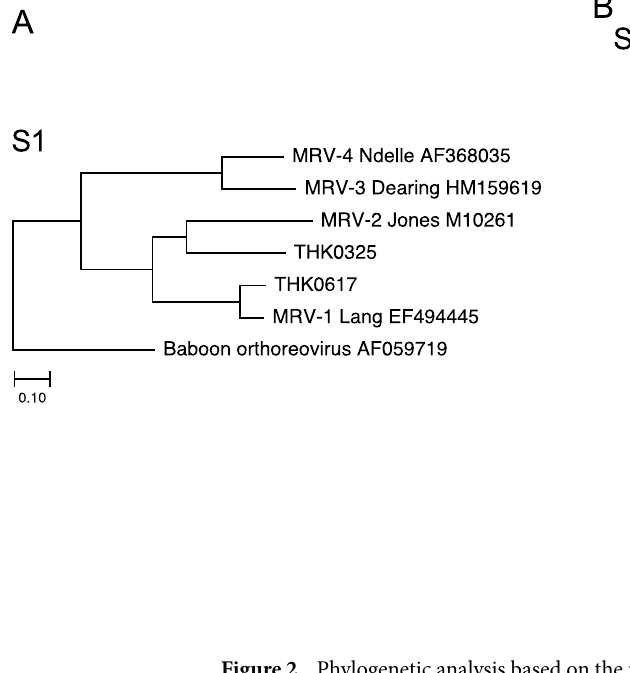
Figure 2. Phylogenetic analysis based on the nucleotide sequences of novel MRV isolates. Phylogenetic trees for the S1 segment were constructed through the maximum-likelihood method and 1000 bootstrap replicates using MEGA software. ( A ) Novel isolates and prototypes. A baboon orthoreovirus sequence was set as outgroup. ( B ) MRV sequences obtained from the GenBank database based on the best hits retrieval from the BLAST result. Each ID depicts the MRV genotype, name, host species, country, and accession number. Solid squares indicate the isolates in this study. Scale bars indicate genetic distances (nucleotide substitutions per